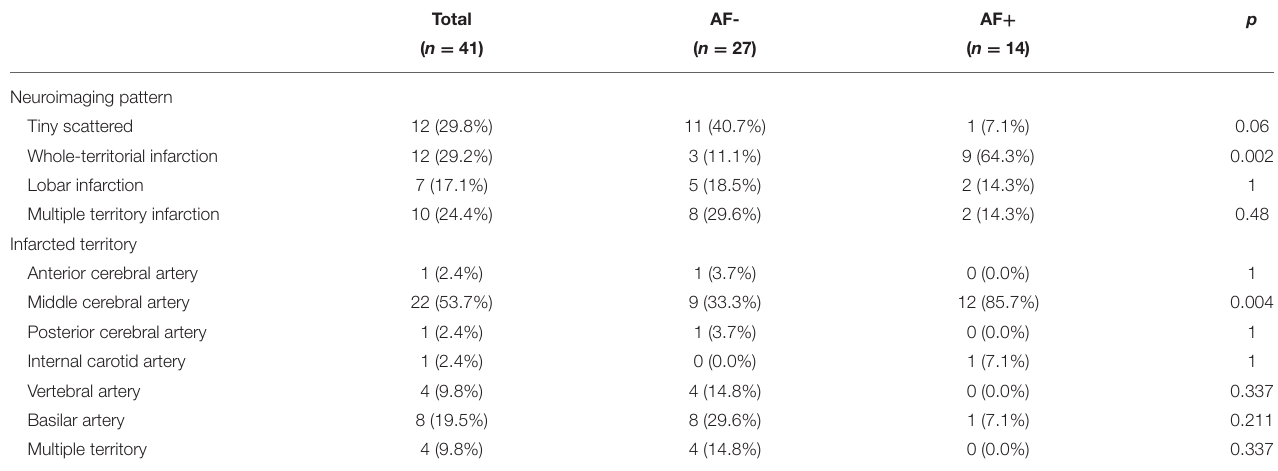
TABLE 2 | Initial neuroimaging pattern.